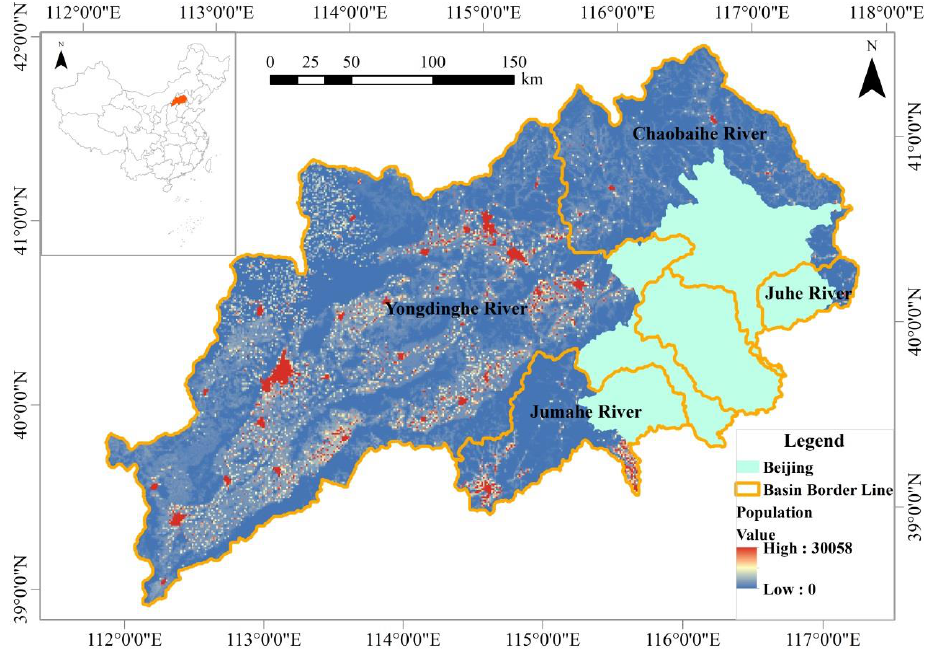
Figure 5. Spatial distribution of population in the study area. Water 2020 , 12 , 622